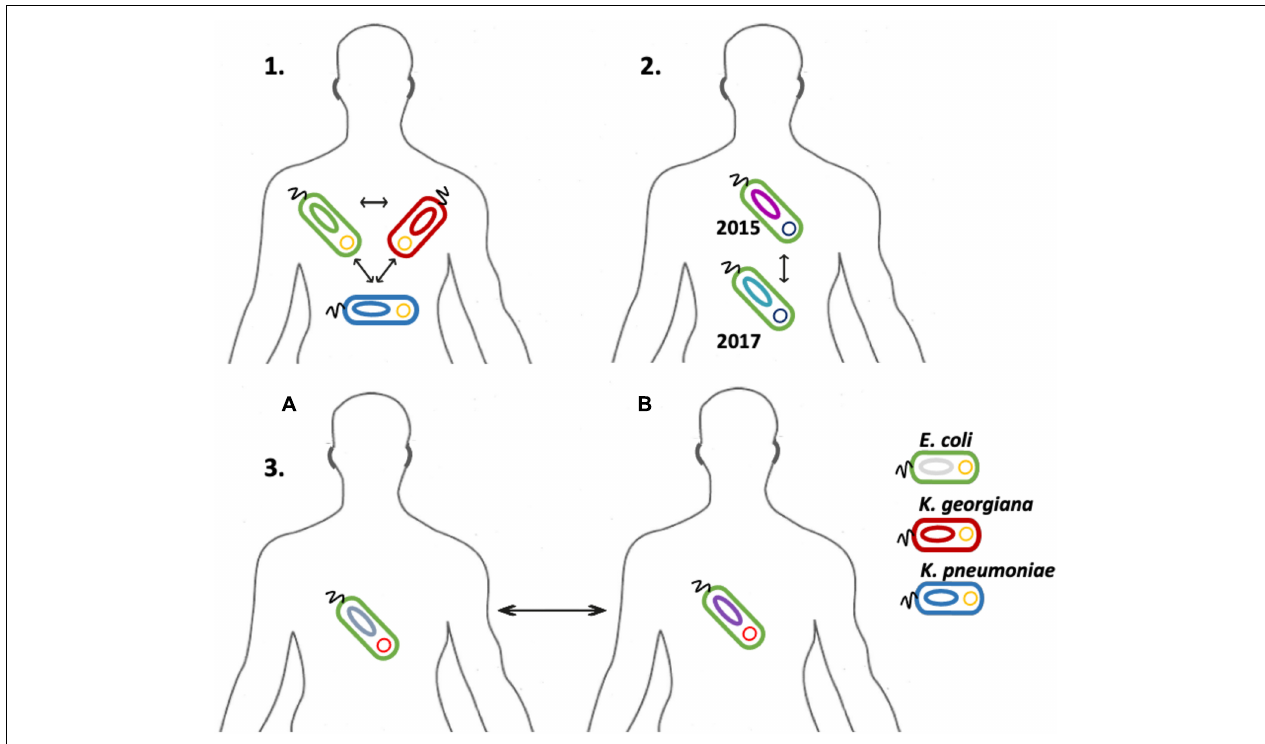
FIGURE 3 | Illustration of the transmission events detected in this study’s dataset. The possible plasmid transfer among species is depicted in three separate cases. Case 1, an IncI2(delta) mcr- 1-carrying-plasmid has been transferred among three different species of E. coli, K. pneumoniae and K. georgiana in a patient. Case 2, an IncI2(delta) mcr- 1-carrying-plasmid was transferred among two different E. coli strains, one isolate detected at 2015 and one at 2017 in the same patient. Case 3, an IncX4 mcr- 1-carrying-plasmid was transferred among two different patients in two different E. coli